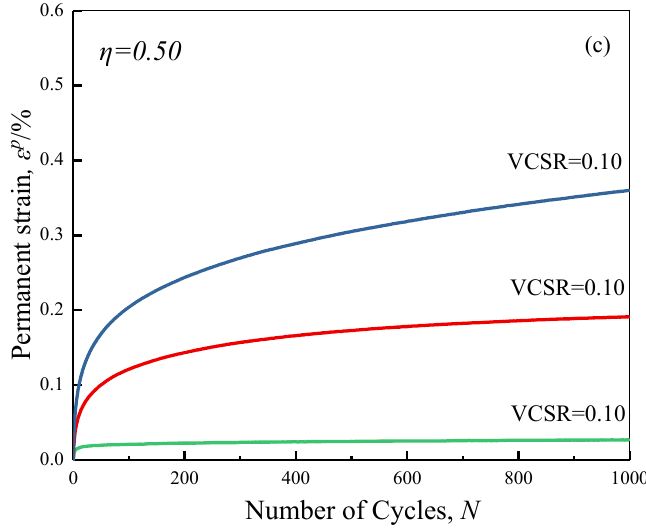
Figure 10. Axial dynamic strain versus number of cycles under different cyclic loading conditions: ( a ) η = 0.00; ( b ) η = 0.25; ( c ) η = 0.50.